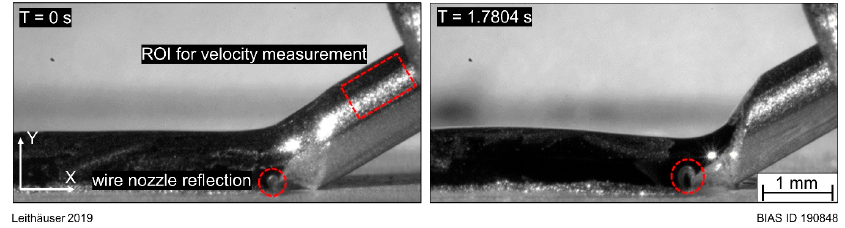
Figure 3. Representative images from the high-speed recording and the regions of interest (ROIs) for the wetting front and wire velocity detection.